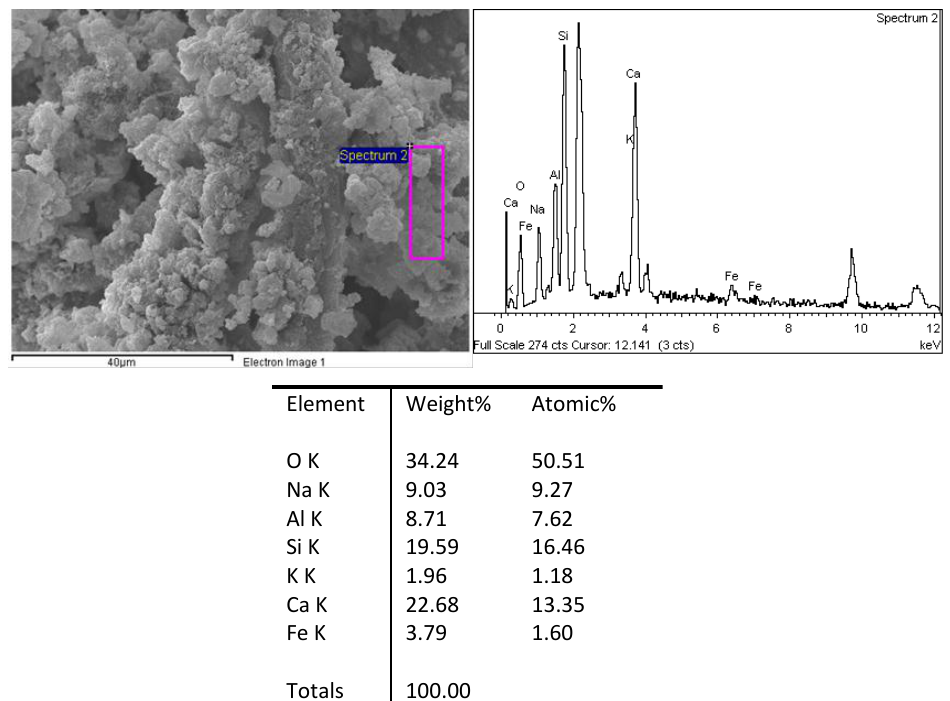
Figure 18. EDS spectrum of alkali-activated cement (Act.3—30%